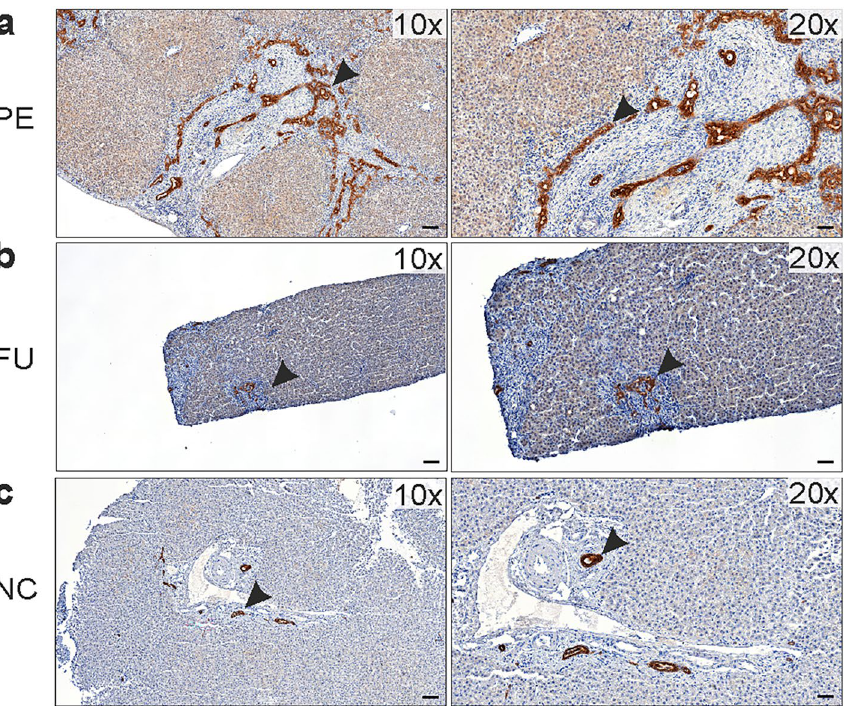
Figure 5. Representative immunohistochemistry on liver expression of secretin receptor (SCTR) in biliary atresia ( a ) at the time of portoenterostomy (PE) and ( b ) during follow-up (FU) 1.4 years after successful PE and ( c ) in a normal control patient (NC). Black arrow heads point to SCTR expressing cholangiocytes (brown). Note SCTR expression in all cholangiocytes including the developing neoductules in the ductular region of biliary atresia patients. Physiological SCTR expression is also seen in large bile duct cholangiocytes of normal